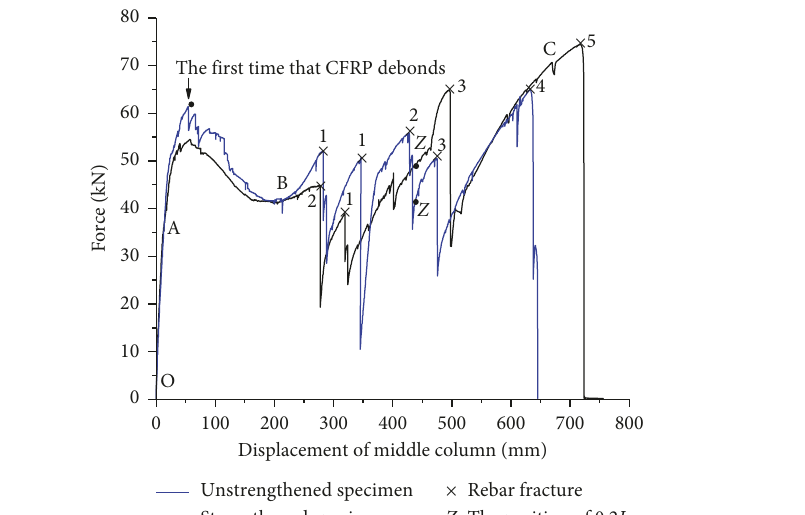
Figure 6: The load-displacement relation curves of the middle column. (1) Bottom rebar near the middle column. (2) Top rebar near the right column. (3) Top rebar near the left column. (4) Bottom rebar near the left column. (5) Top rebar near the middle column.